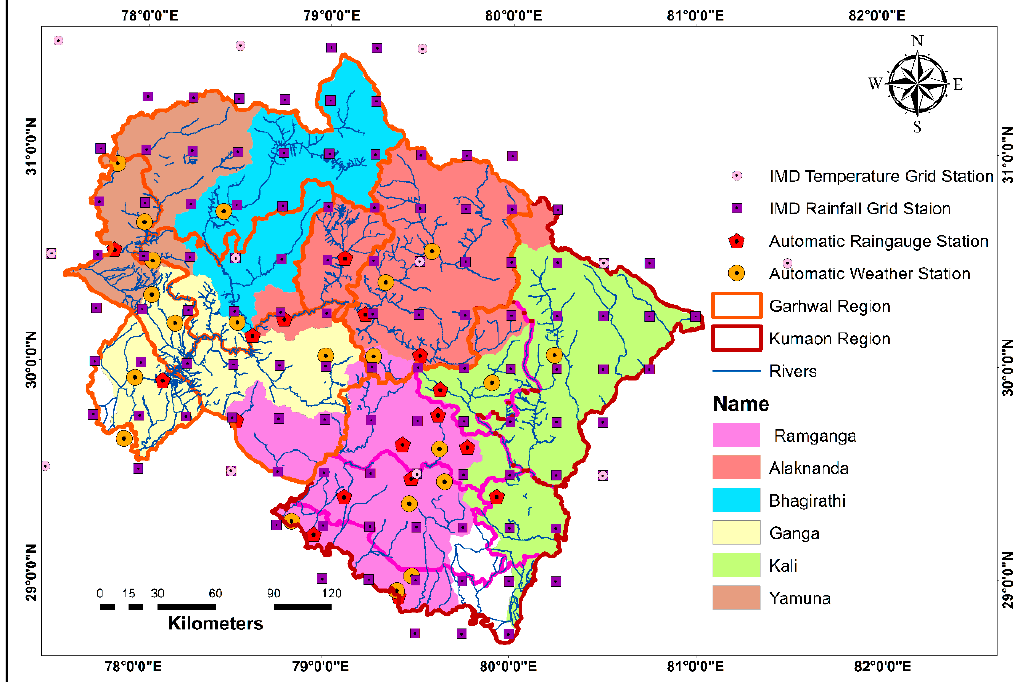
Figure 2. The spatial distribution of IMD-ARG and IMD-AWG along with the major river basins in the state of Uttarakhand.